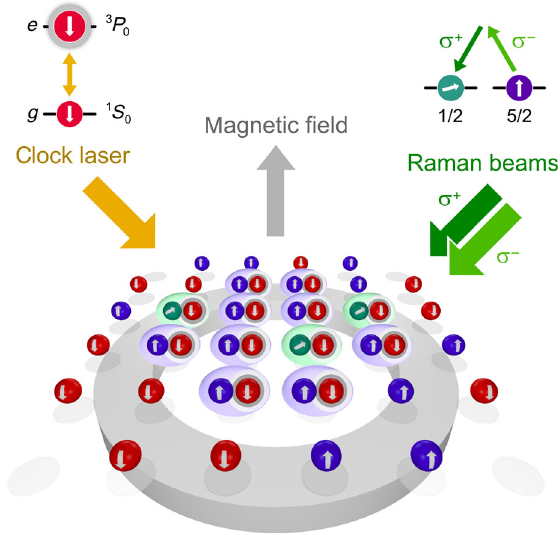
FIG. 1. Sketch of the experimental system. Ultracold 173 Yb atoms are trapped in optical lattices (of variable dimensionality depending on the specific experiments). The electronic (orbital) state is manipulated by an ultranarrow clock laser, while a pair of Raman laser beams controls the nuclear-spin state. Interactions between atoms in different internal states are controlled with a magnetic field tuned in proximity of the orbital Feshbach